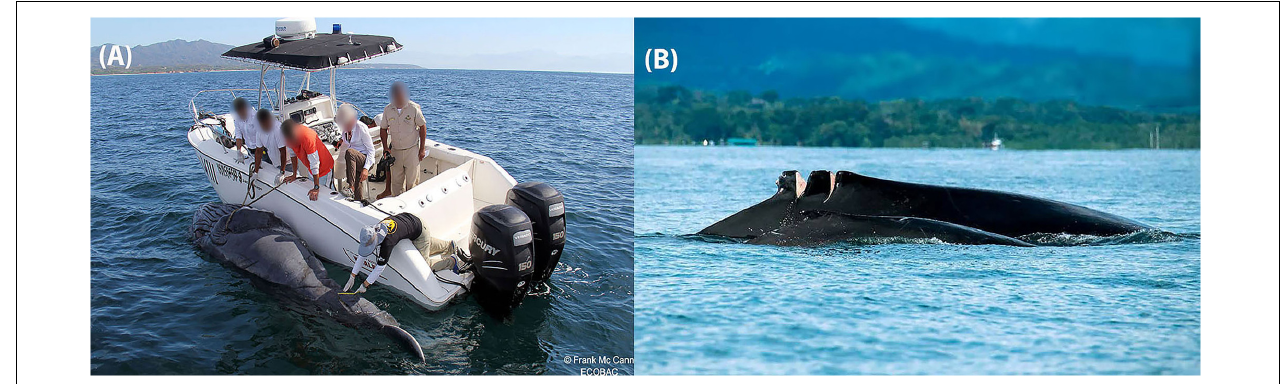
FIGURE 4 | (A) The carcass of a humpback whale calf (4.3 m in length) found floating in the Bay of Banderas, Nayarit, Mexico (December 31, 2014), with several deep, parallel cuts, some of which extended through the spinal column. Vessel strike was the concluded cause of death (Information and image: ECOBAC, Jalisco, Mexico). (B) A female humpback whale and calf photographed in Golfo Dulce, Costa Rica (September 16, 2017), showing open and fresh sharp trauma injuries, likely caused by a large ship’s propeller (Image: Deivis Salazar Ruiz, Acacia Tours).